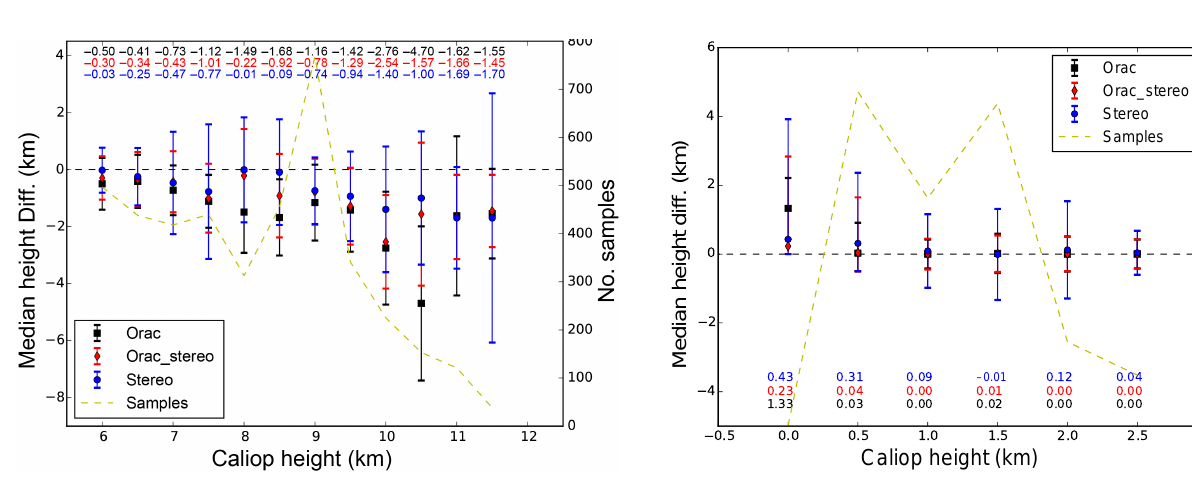
Figure 6. Error bar plot plotting the median height differences for single-layer ice clouds (over water where ORAC and ORAC + stereo phase agrees) at or above 6km (as determined by CALIOP) for the three algorithms applied to AATSR and the elevation of the CALIOP CTL, as a function of the elevation of the CALIOP CTL at 500m intervals (in this instance the median is derived from all collocated data contained within set given by the CALIOP CTL el- evation indicated on the x axis and all CALIOP CTL samples which are located within the following 500m, e.g. 6km ≤ CTL<6.5km). The three statistics above each error bar are the median differences. The error-bar whiskers represent 1 standard deviation.